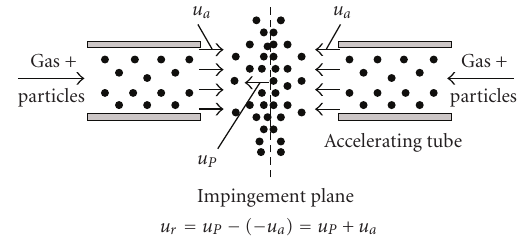
Figure 1: Original idea of impinging streams